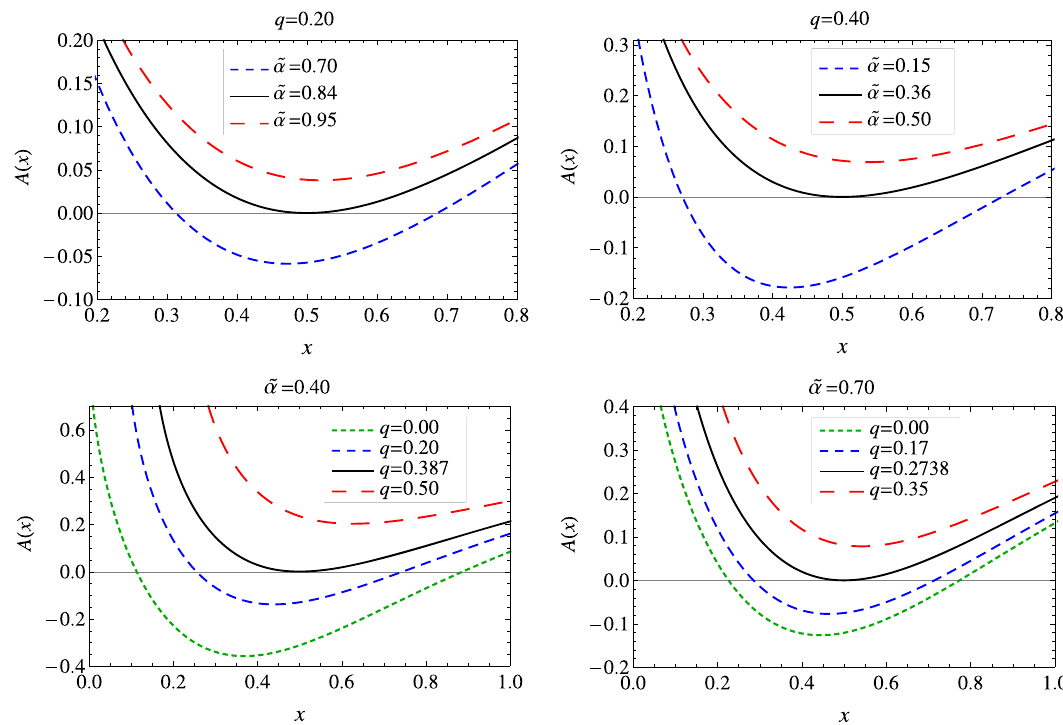
Fig. 2 (Upper panel) Plot showing the horizons for various values of GB coupling parameter ˜ α and fixed values of q . (Lower panel) Plot showing the horizons for different values of q and fixed ˜ α . The black solid lines correspond to the extremal black holes